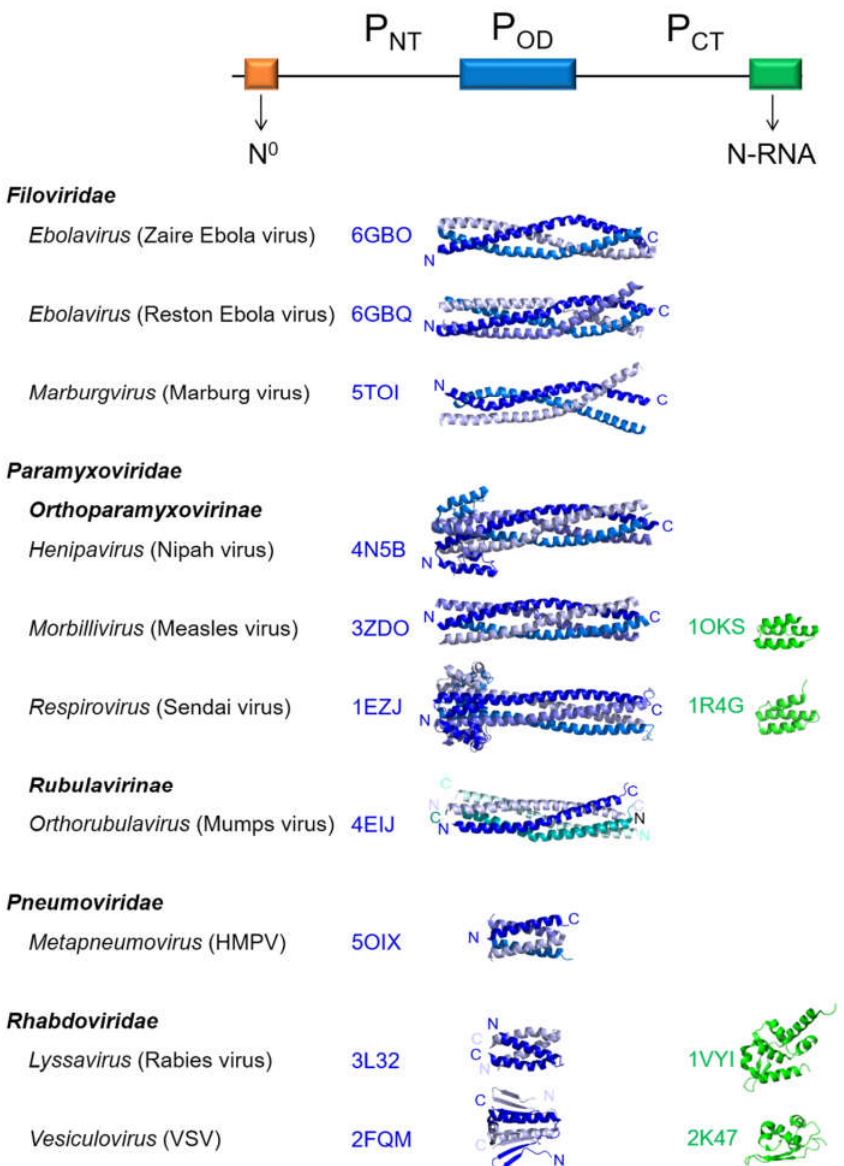
Figure 1. Overall architecture of the Mononegavirales phosphoproteins (P) and the structural diversity of the individual domains. On top is shown a scheme of the P protein, with the 3-fold repartition between the N - and C -terminal regions (P NT and P CT ), comprising distinct binding sites for the nucleoprotein (N), either as monomeric N 0 or as an N-RNA complex, separated by an oligomerization domain (P OD ). Representative structures are shown below, in cartoon, for P OD (protomers are in different shades of blue) and the C -terminal N-RNA-binding domains (green), for viruses belonging to the Filoviridae , Paramyxoviridae , Pneumoviridae and Rhabdoviridae families. PDB codes are indicated next to the structure. Sub-families and genera are indicated in bold and regular font, respectively. Virus names are given in parentheses. N - and C -termini are indicated by N and C letters. For parallel oligomers, this indication is given only for the first protomer.